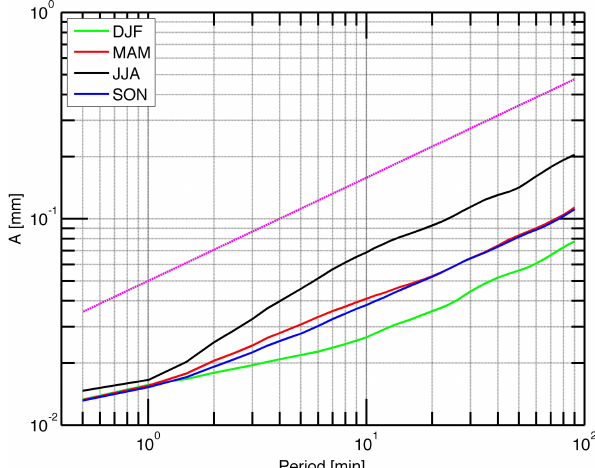
Figure 2. Amplitude spectra of IWV fluctuations observed at Bern in summer 2010. The solid black line is obtained by a band pass filtering method. The green line shows the inclination for A ∼ T 0 . 5 p where T p is the period. The corresponding power law is given by P ∼ f − 1 , where f is the frequency. The blue line is obtained by a fast Fourier transform of the complete summer 2010 time interval. The red line shows the inclination for A ∼ T 1 p (or power P ∼ f − 2 ). The FFT method underestimates the amplitudes and overestimates the steepness of the inclination.